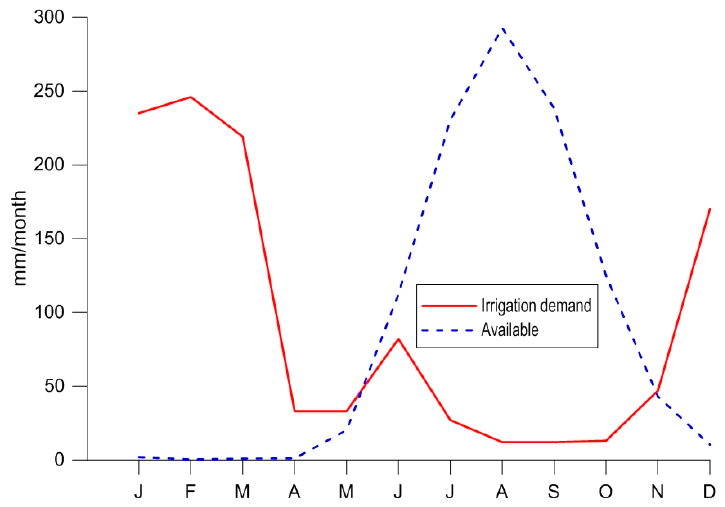
Figure 11. Scheme of Irrigation demand in mean monthly and available water in Gilgel Abbay watershed (long term average of 1993–2012); where the irrigation demand scheme is obtained from Tana sub basin research center in mean monthly, Bahir Dar, Ethiopia.